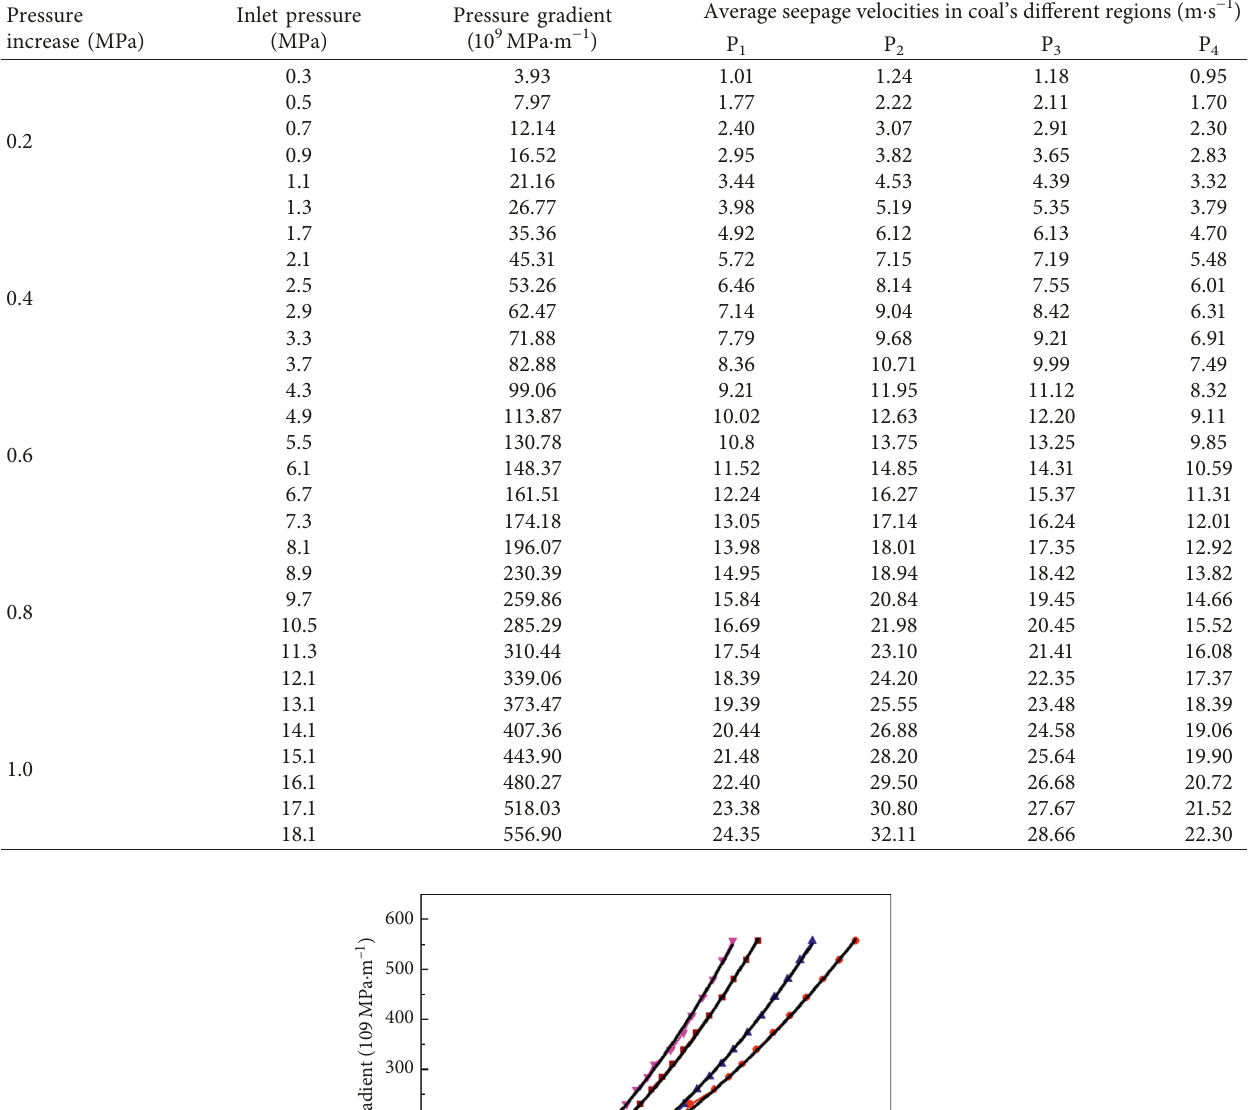
Table 3: Average seepage velocities in coal seams under different pressure gradients.